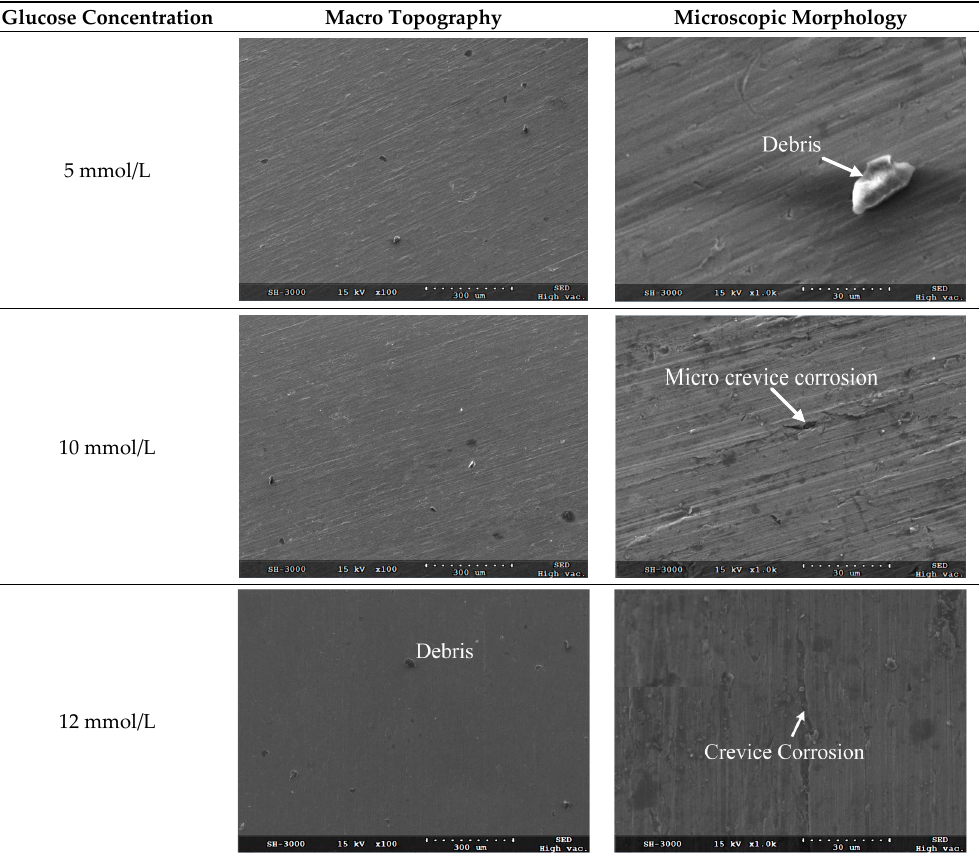
Table 5. Electrochemical corrosion parameters determined by Tafel curves.